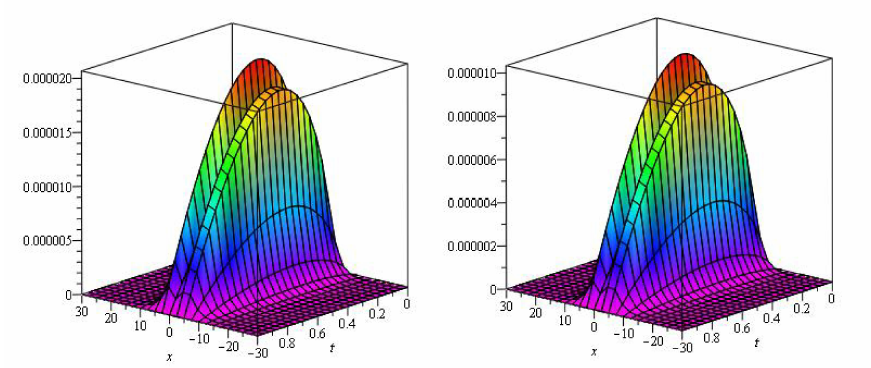
Figure 2. Error graphs of µ ( ζ , τ ) and ν ( ζ , τ ) at ρ = 1 and η = 0.001 of example